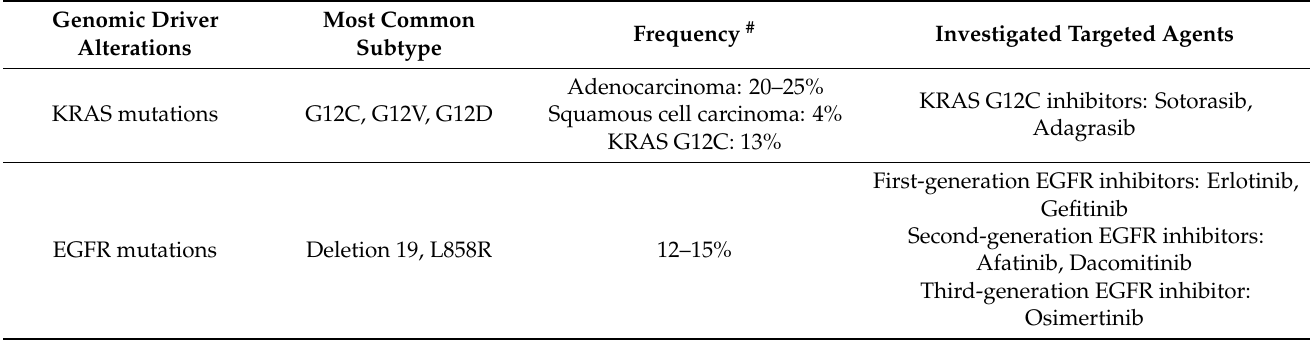
Table 1. Molecular oncogenic driver aberrations, their frequency and targeted